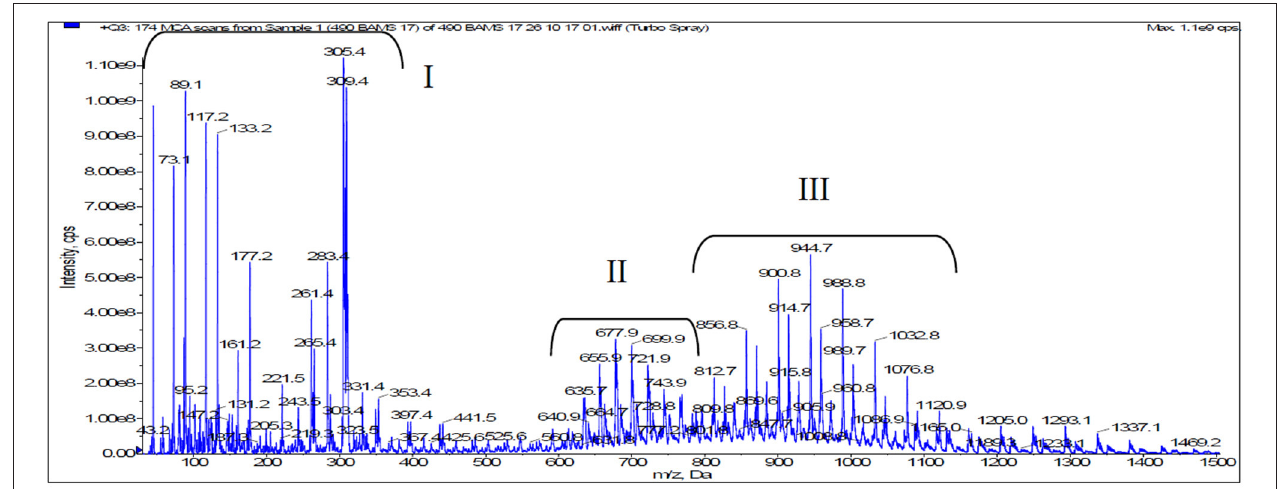
FIGURE 5 | Sample ESI MS spectrum of the tested LEE sample (N AV =